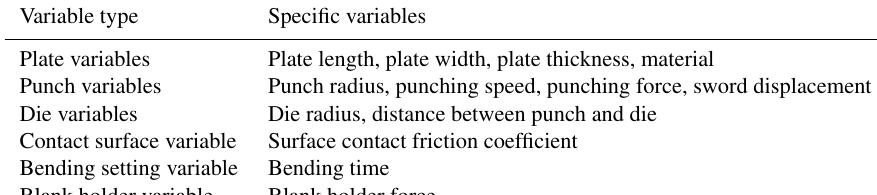
Table 2. Influencing factors of springback in local bending.